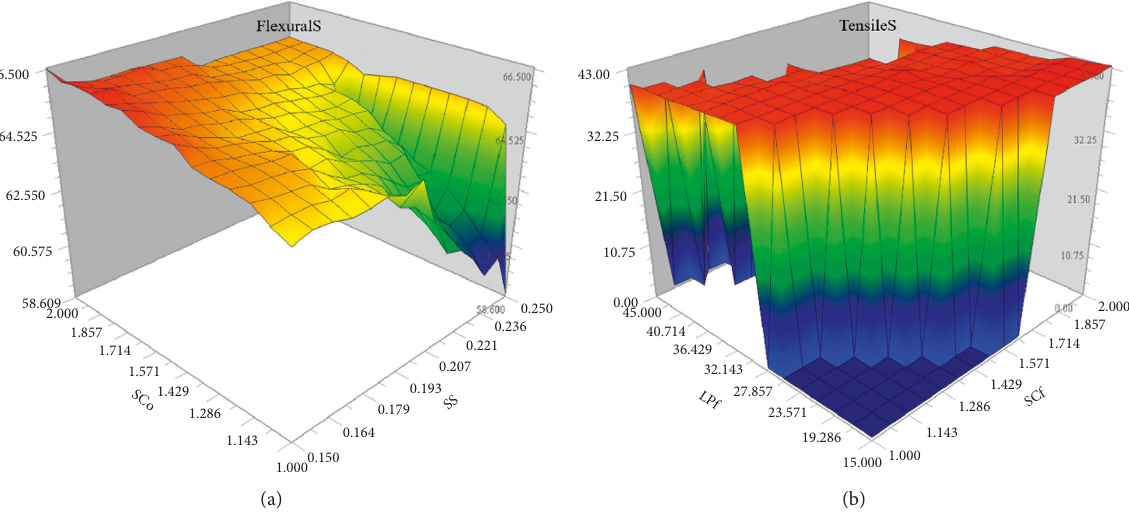
Figure 12: The 3D response surface plots for (a) flexural and (b) tensile strength.